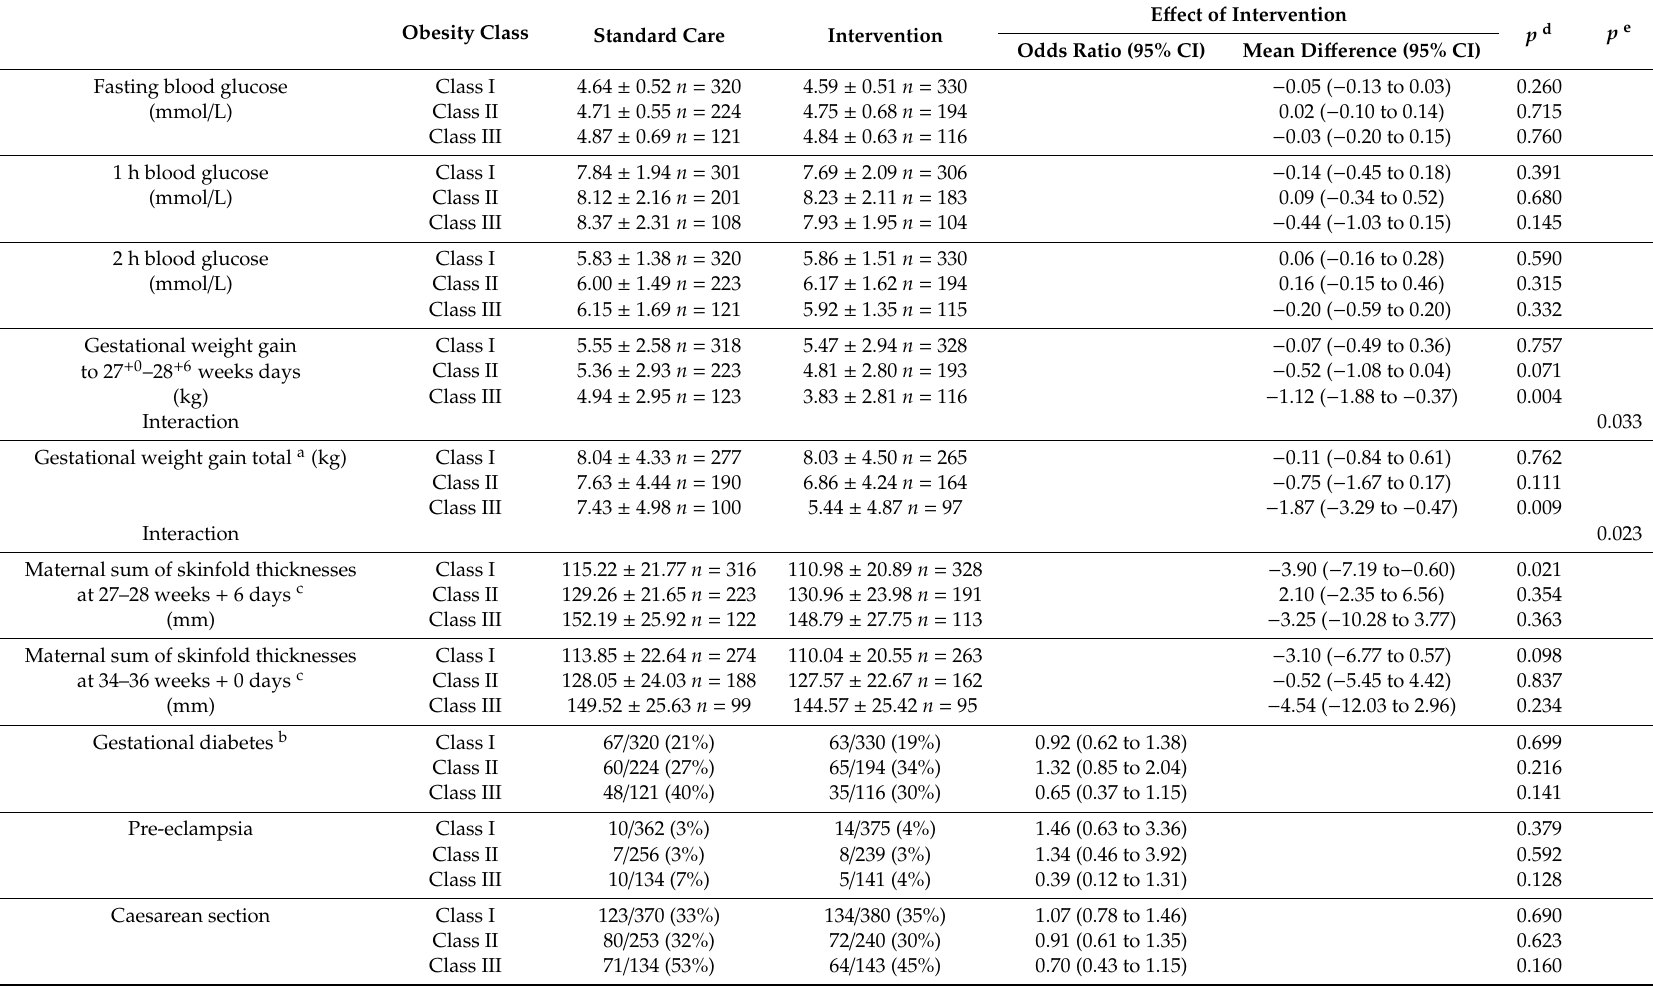
Table 3. Maternal and neonatal outcomes by intervention group and obesity